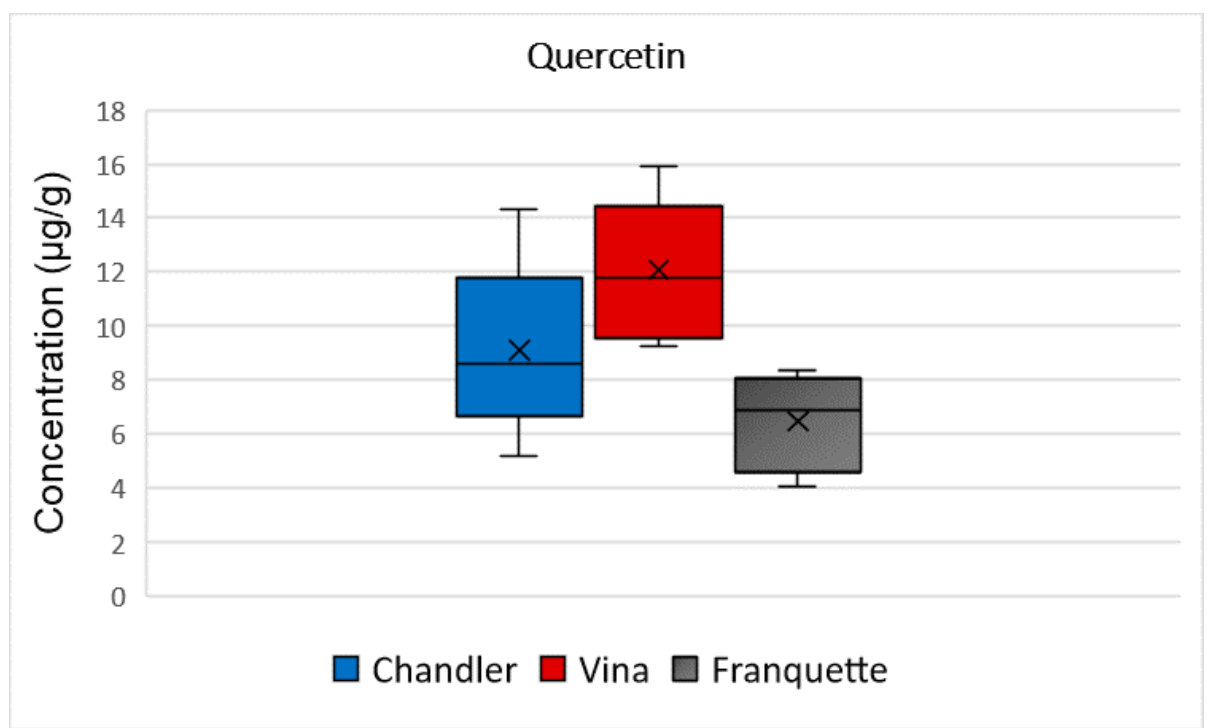
Figure 5. Box and Whisker plot for the concentration of luteolin among walnut septa belonging to the Chandler, Vina, and Franquette varieties.